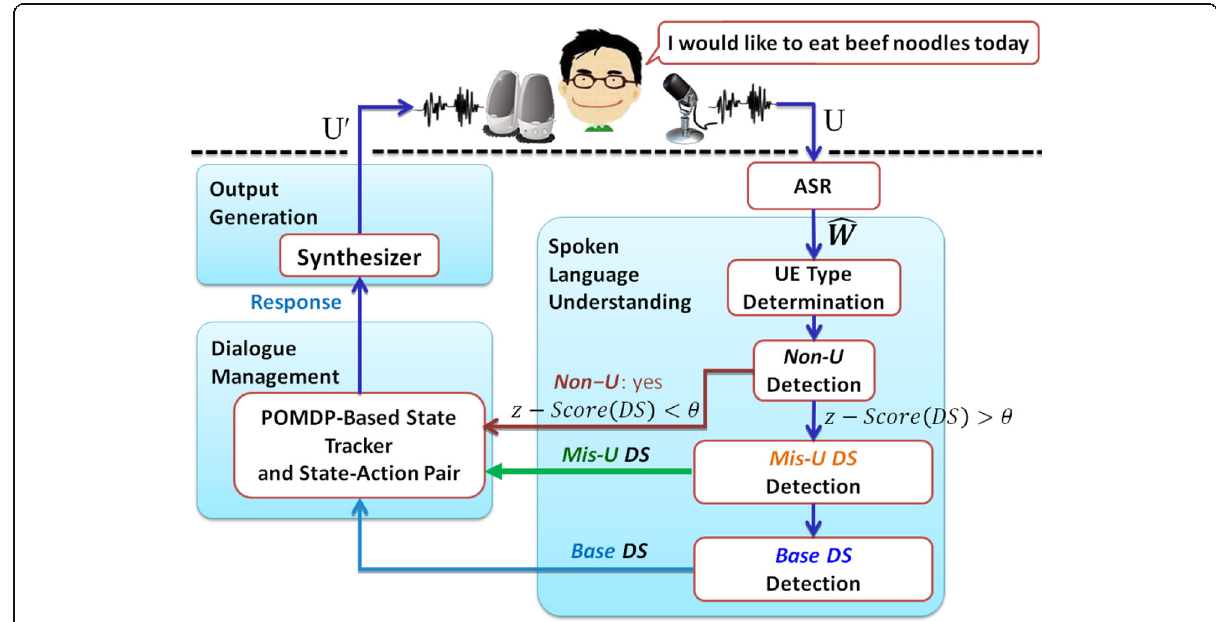
Fig. 6 The basic concept of the proposed SDS for miscommunication